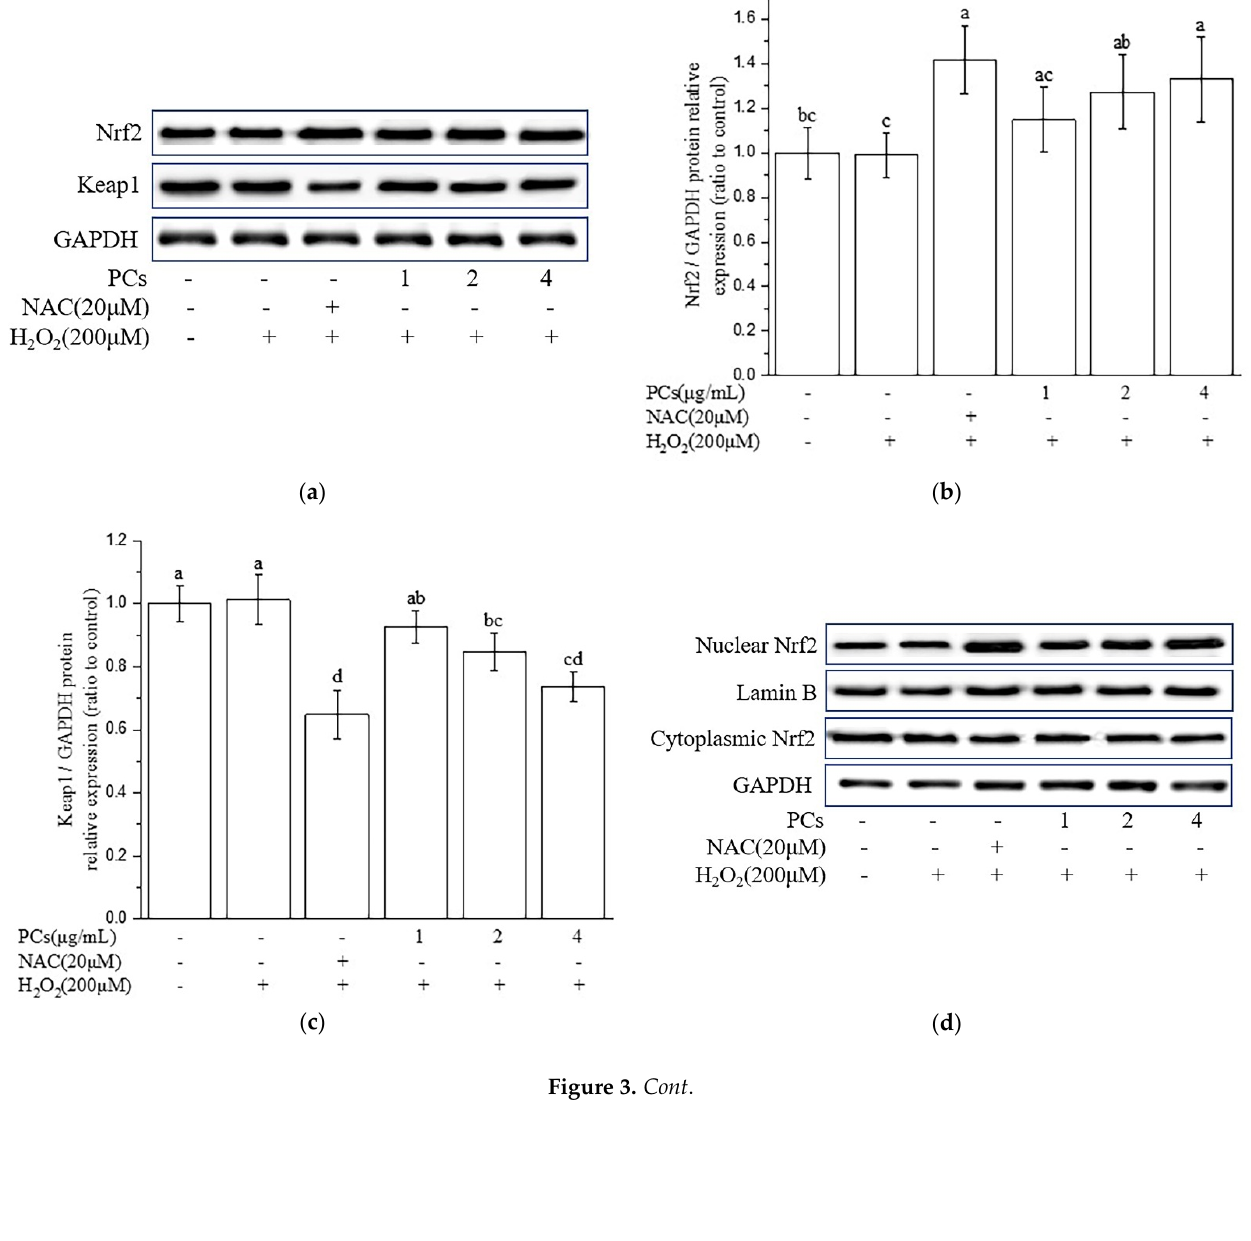
Figure 2. PCs attenuate H 2 O 2 -treated oxidative stress and increase antioxidant activities in PC12 cells. ( a ) Representative fluorescence photomicrographs of PC12 cells; ( b ) ROS levels were measured by software; ( c ) MDA levels; ( d ) GSH-Px activity; ( e ) CAT activity; ( f ) SOD activity. Data are expressed as the mean ± SD. All experiments were conducted three times. Values with different letters above are significantly different ( p < 0.05, one-way ANOVA).